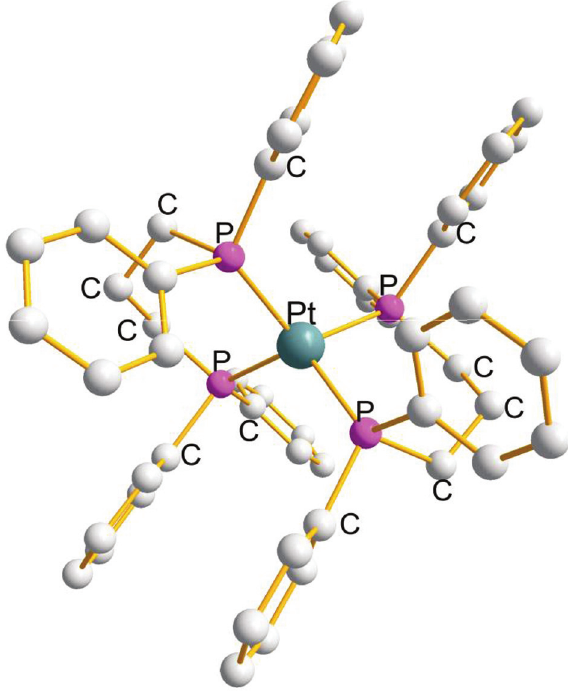
Figure 2: Structure of monoclinic [Pt{ η 2 -Ph et al.,